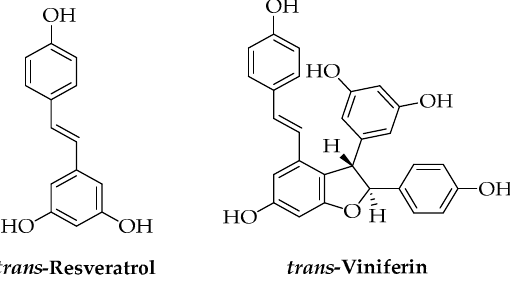
Figure 6. Chemical structure of the most important stilbenes.